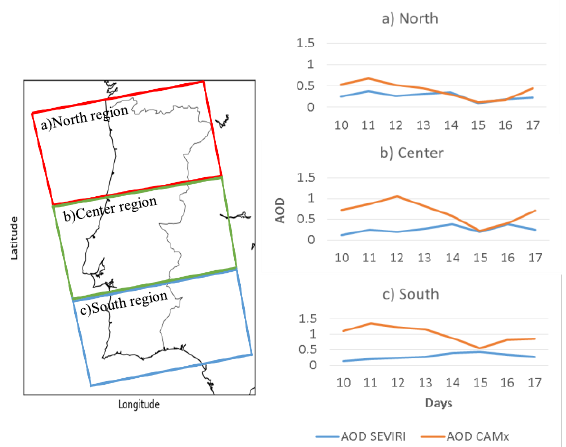
Figure 12. Daily mean AOD values obtained from CAMx results and SEVIRI observation for each region a) North (red box), b) Center (green box) and c) South (blue box) for the period 10th -17th May